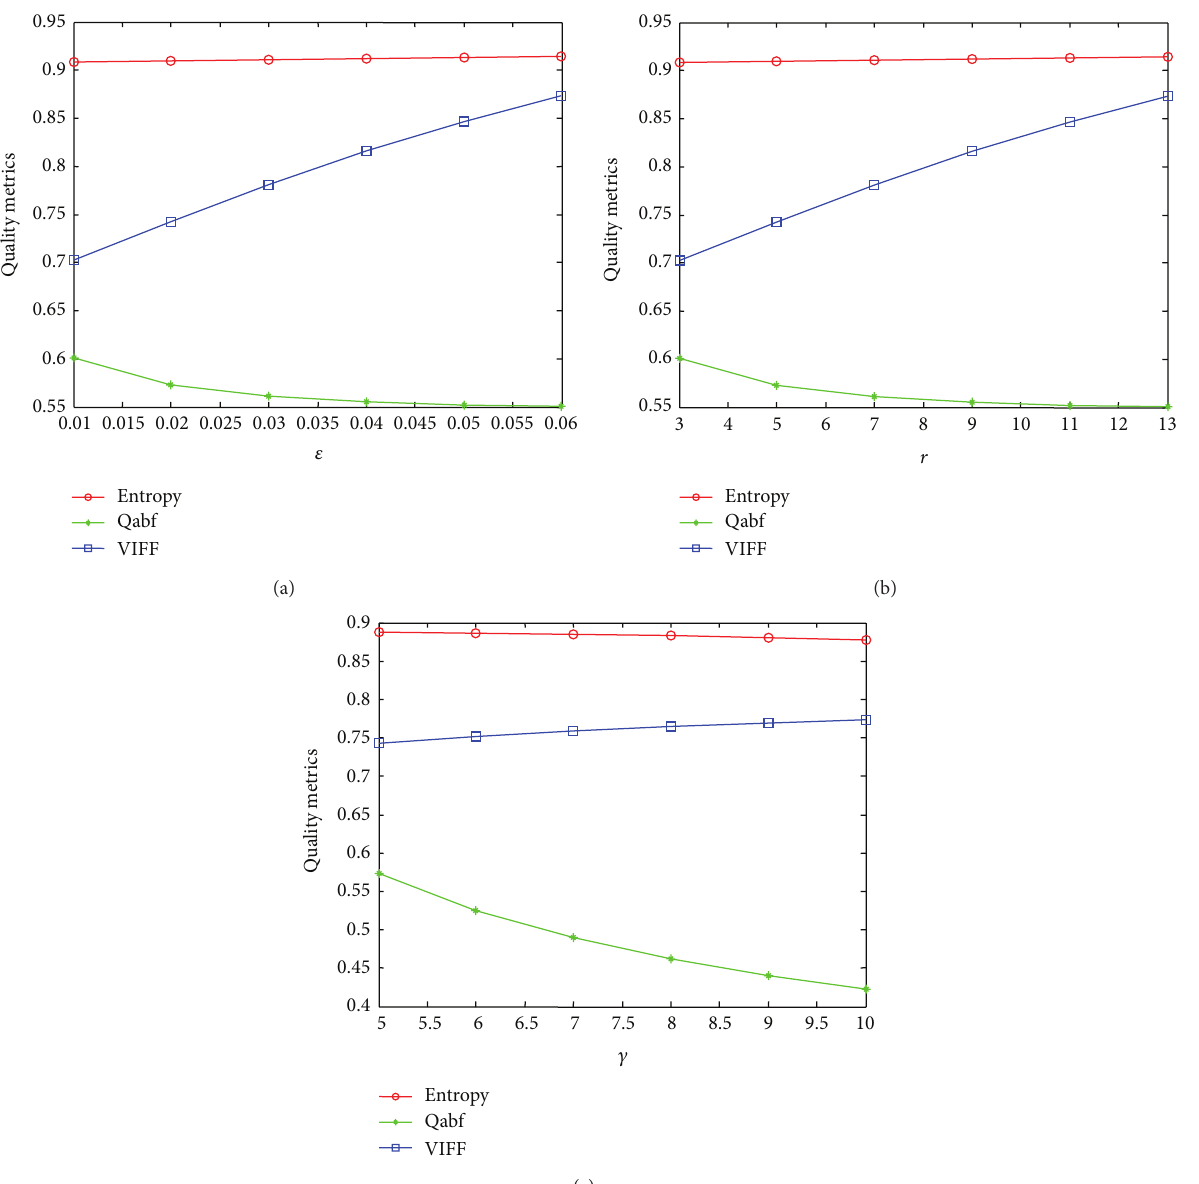
Figure 7: Analysis of different free parameters used in the algorithm. Maximum quality score and entropy are only observed when 𝜀 = 0.01 , 𝛾 = 5 , and 𝑟 = 2 (which are set as default parameters). It is observed that VIFF increases as 𝜀 , 𝛾 , and 𝑟 increases but the larger values are responsible for overenhancement. (a) Effectiveness of 𝜀 on metrics, (b) effectiveness of 𝑟 on metrics, (c) effectiveness of 𝛾 on